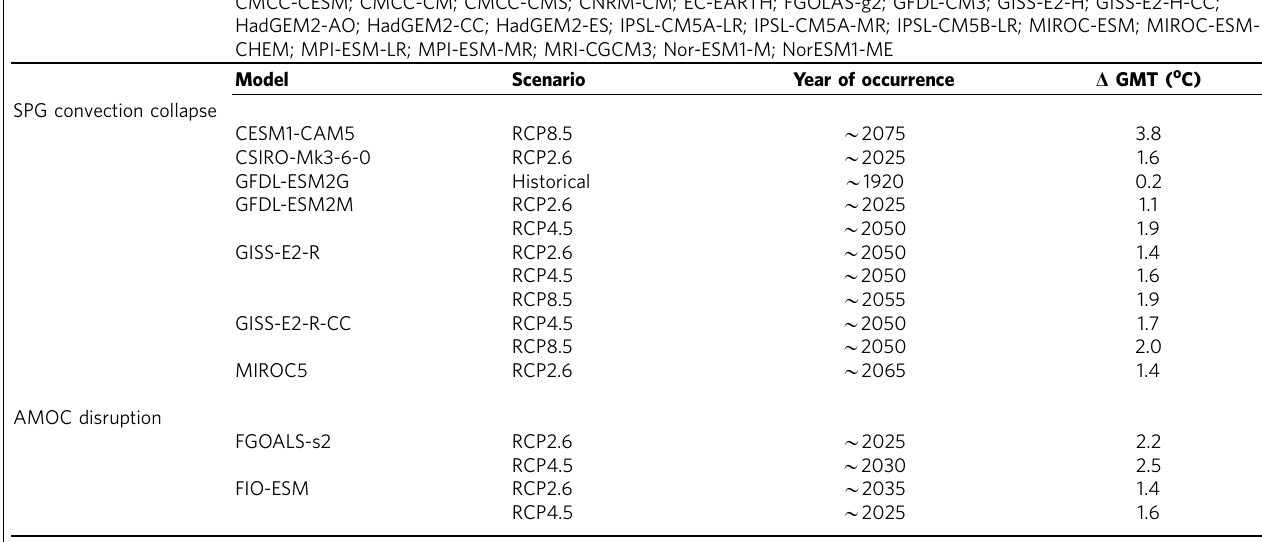
Table 1 | Classification of CMIP5 models in the three sub-ensembles. Subset